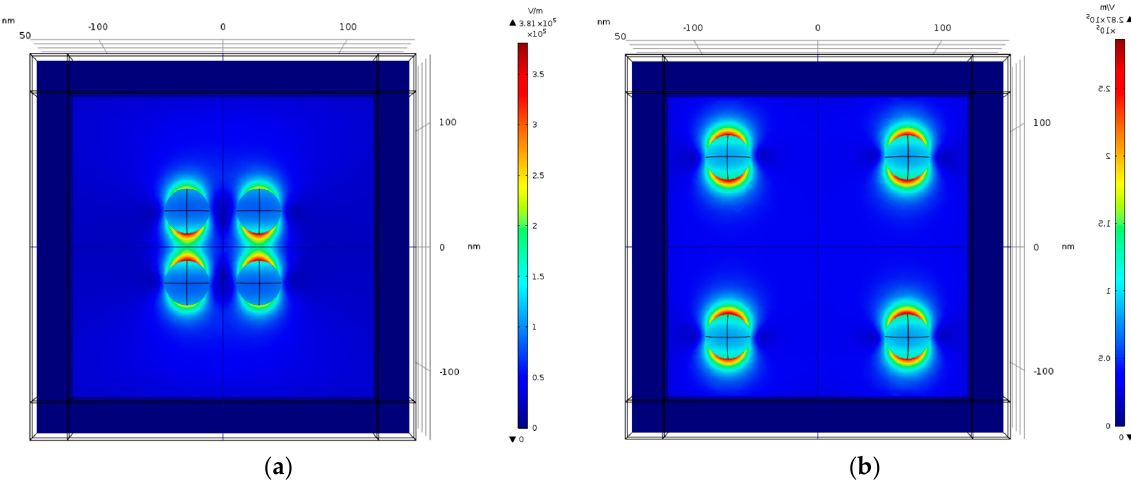
Figure 23. Simulation of separated hemi-spheroid nano-particles. ( a ) Separation of 20 nm; ( b ) separation of 110 nm. The width of physical geometry W = 250 nm. The electric field polarization is in the Y direction, therefore the localized surface plasmon is excited mostly in that direction. There is less interaction between nano-particles separated in the X direction.